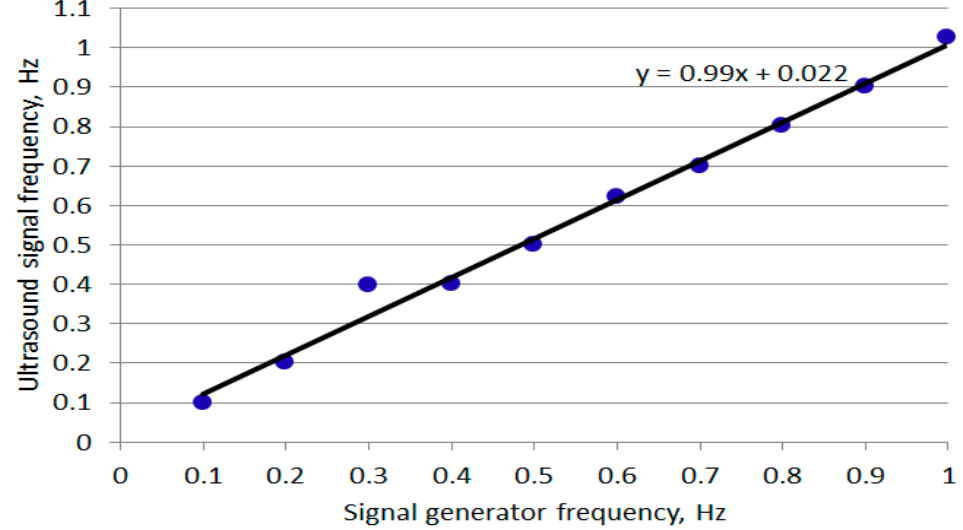
Figure 5. Plot of ultrasound-measured signal frequency against signal generator frequency